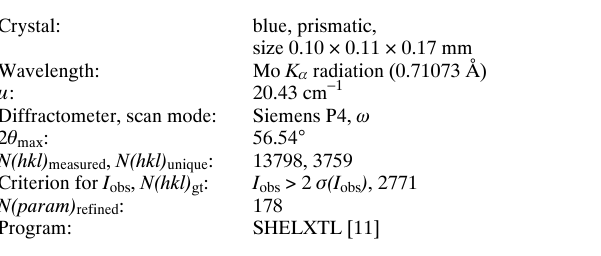
Table 1. D a t a collection a nd h a ndling.